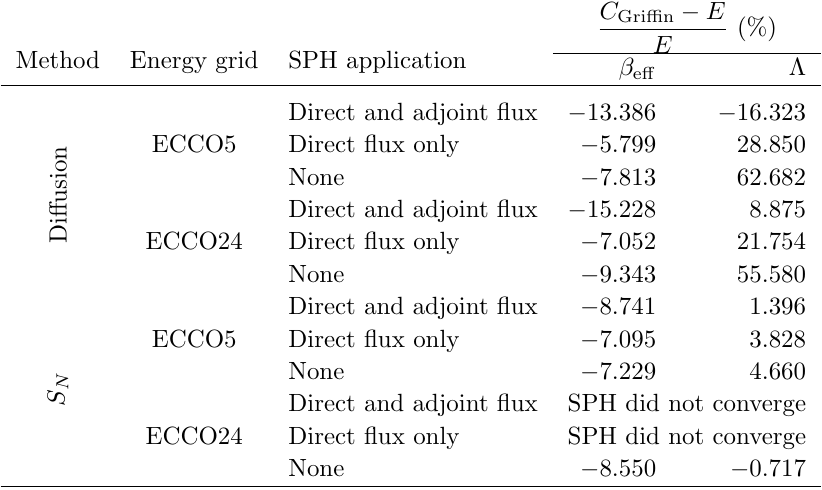
Table 22. Relative differences between Griffin and Flattop-23 benchmark kinetics